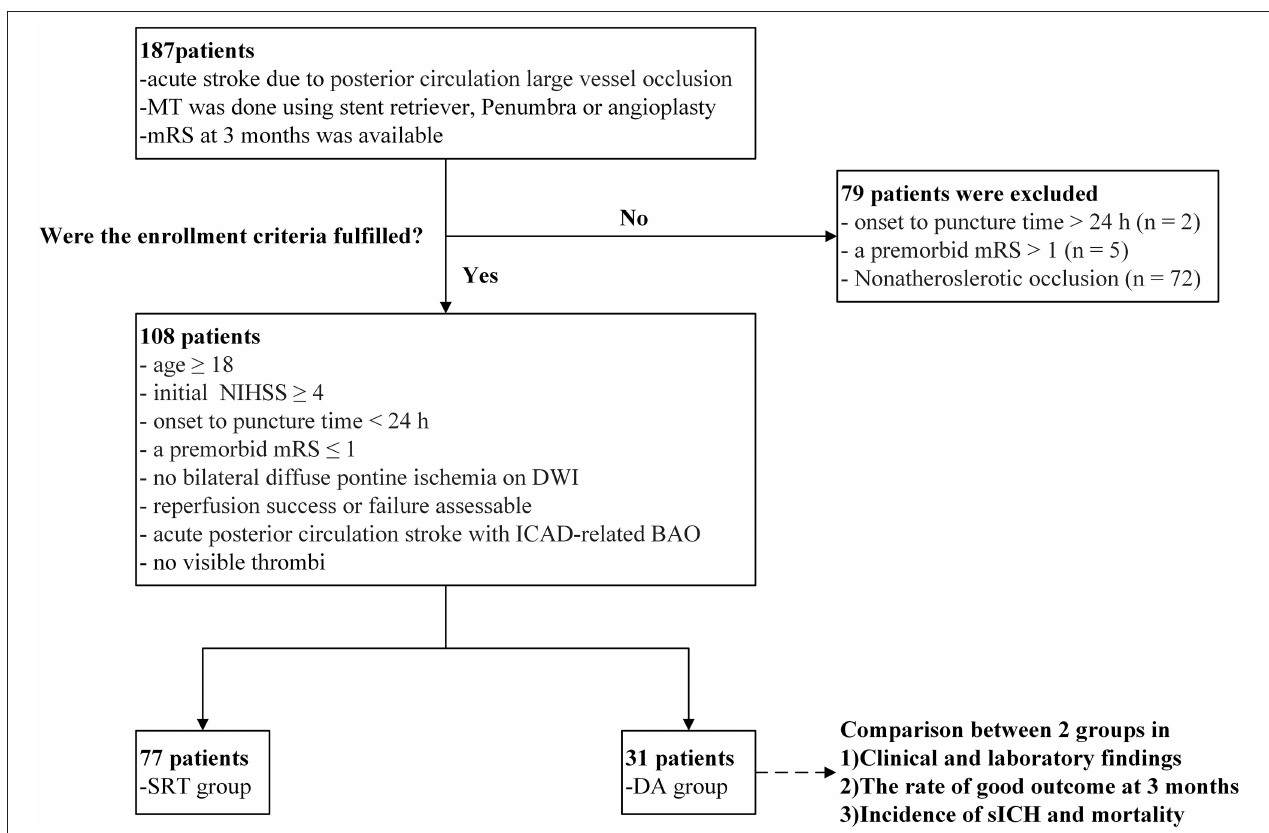
FIGURE 1 | Flow chart of patient inclusion criteria and findings analyzed at each